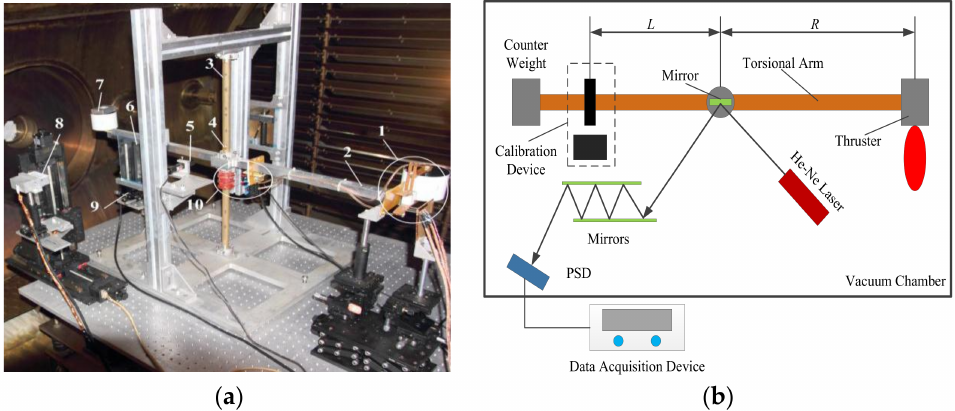
Figure 6. Torsional pendulum: ( a ) physical map; ( b ) schematic illustration.